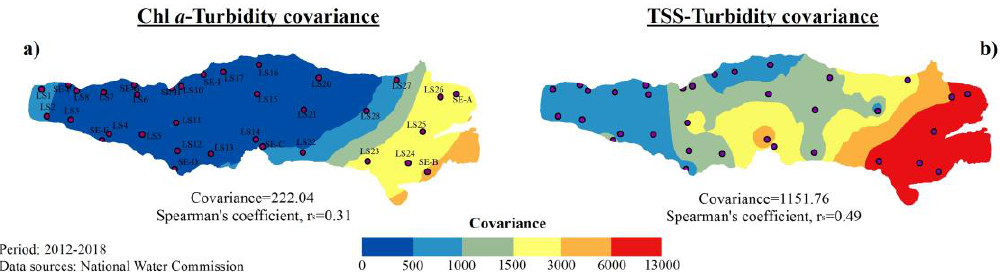
Figure 2. Geostatistical analysis in Lake Chapala, ( a ) covariance between Chl a and turbidity, ( b ) covariance between TSS and turbidity.